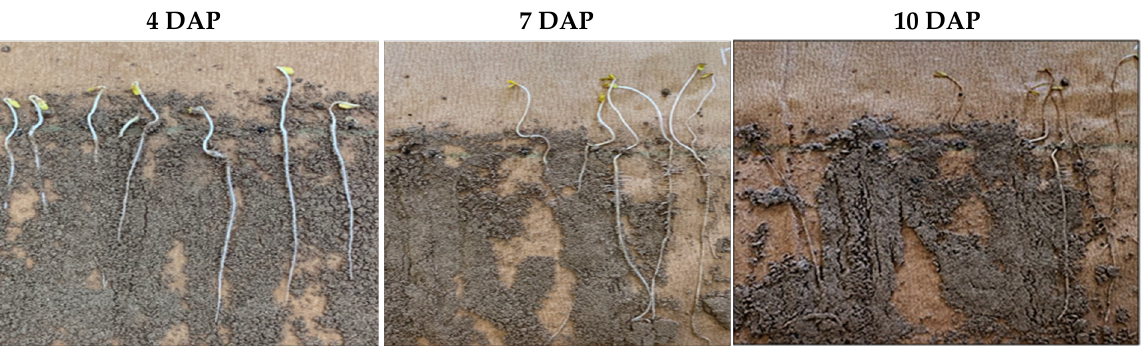
Figure 1. Soil bioassay naturally infested with Pythium aphanidermatum . Ratings were recorded 4, 7 and 10 days after planting (DAP).